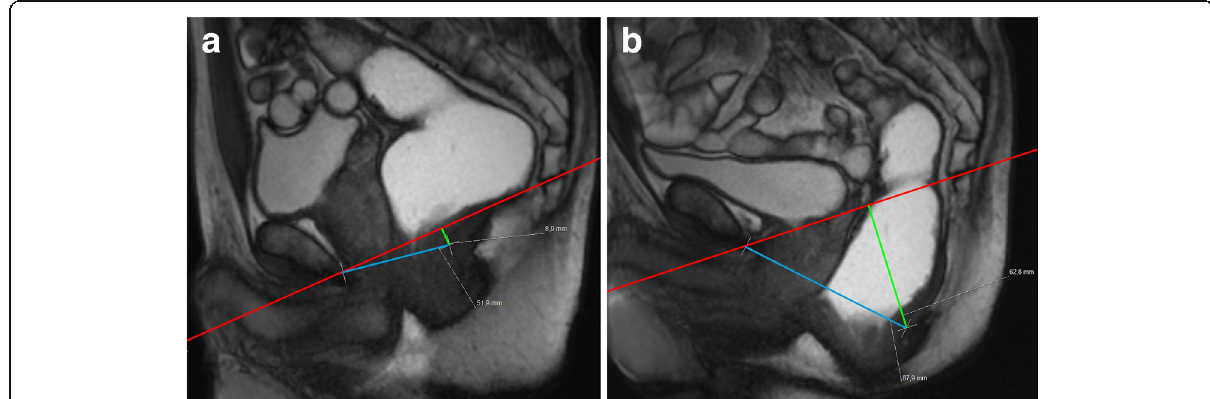
Fig. 20 Descending perineal syndrome in a man. ( a , b ) Sagittal midline TrueFISP images at rest ( a ) and during evacuation ( b ) of a man with complaints of constipation and incomplete evacuation showing an increase of the H and M lines during evacuation phase (blue line, 88 mm; green line, 63 mm respectively), compatible with descending perineal syndrome with increased hiatal width and